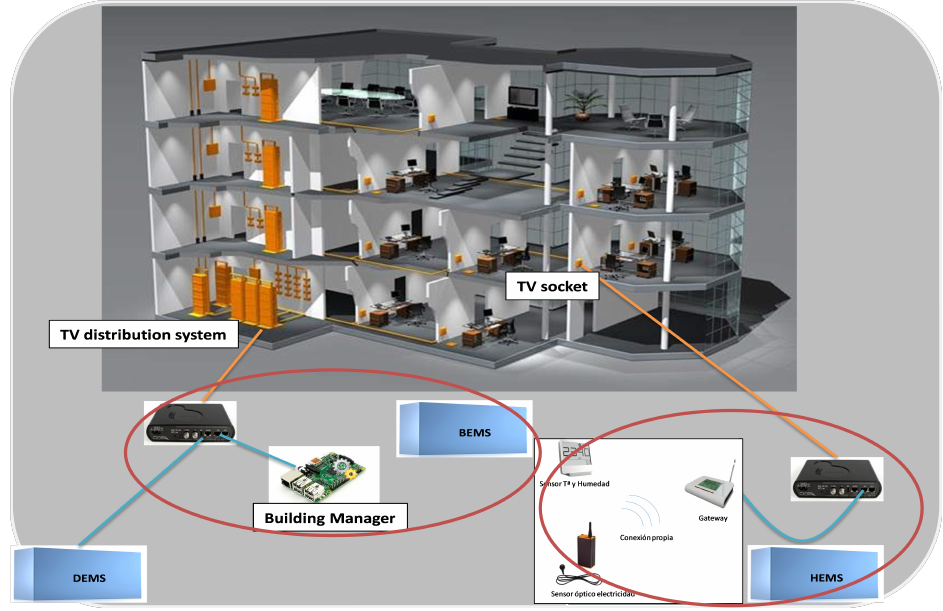
Figure 4. Sensor and device infrastructure at dwelling